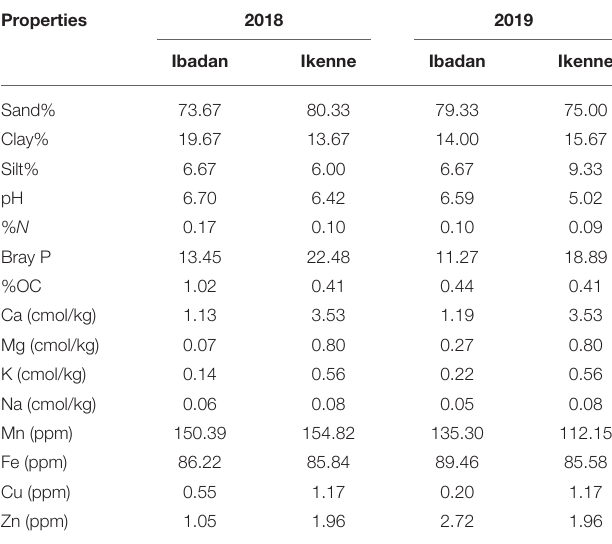
TABLE 3 | Soil properties at the beginning of the experiment for individual locations and